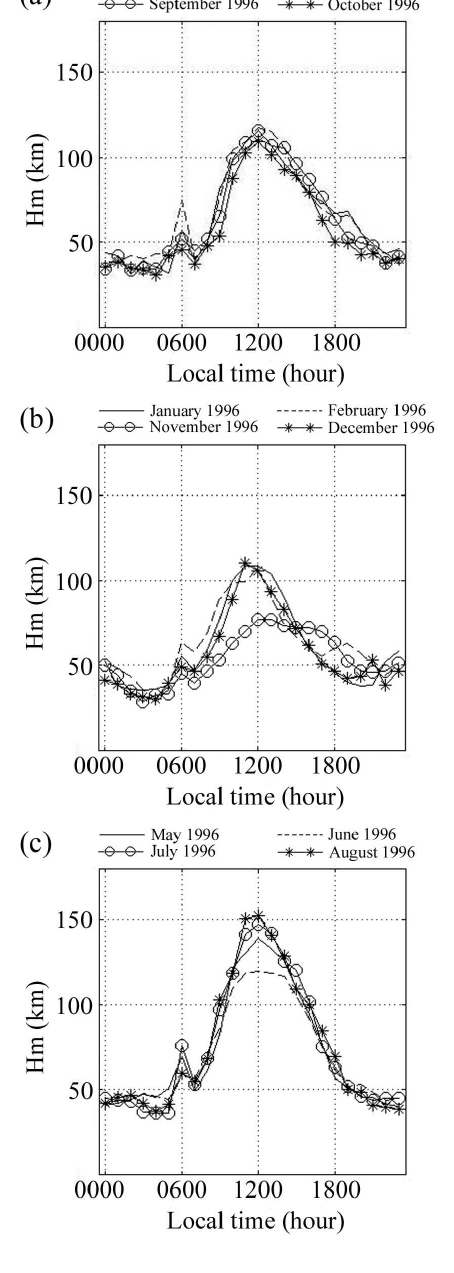
The monthly smoothed sunspot numbers (SSN)